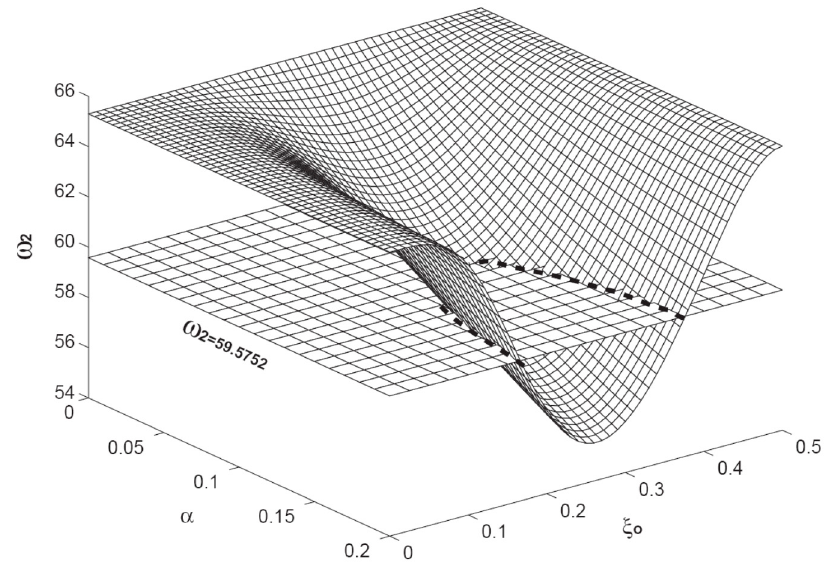
ω ) as a function of α and 2